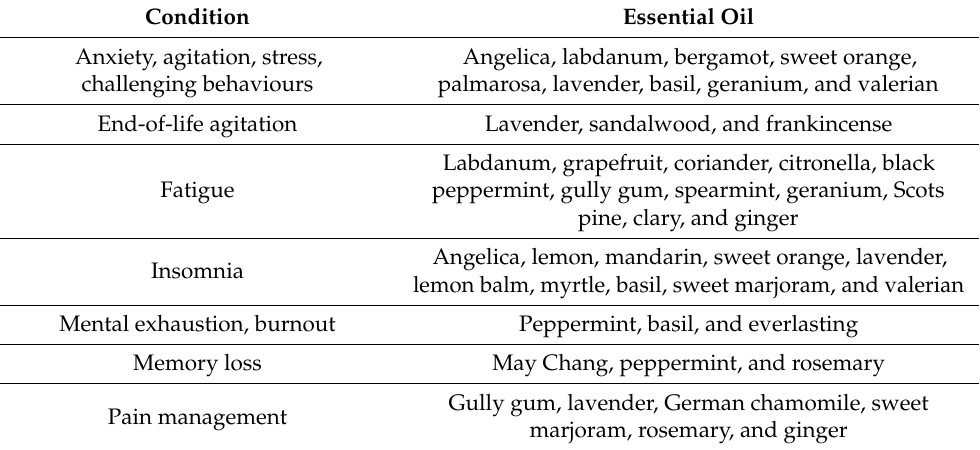
Table 4. Some pharmacological actions of essential oils